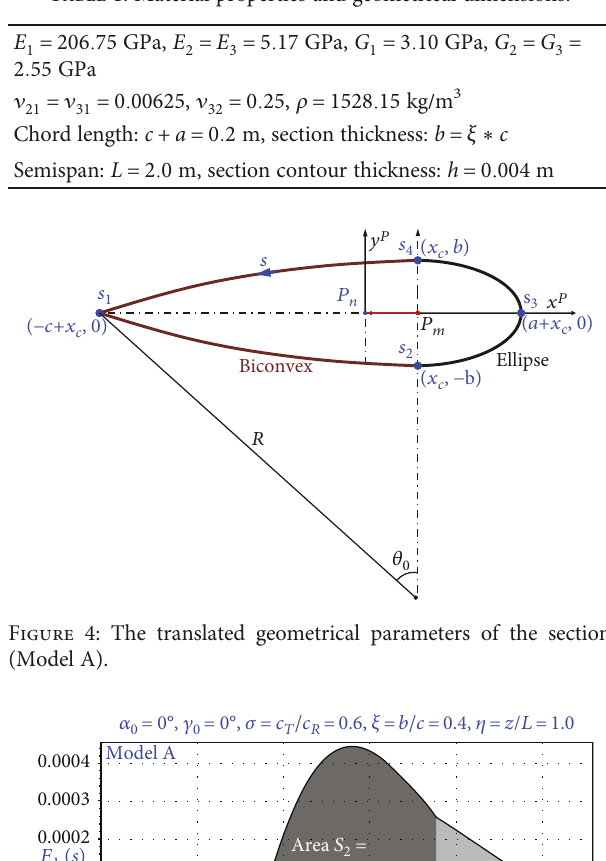
Table 1: Material properties and geometrical dimensions.